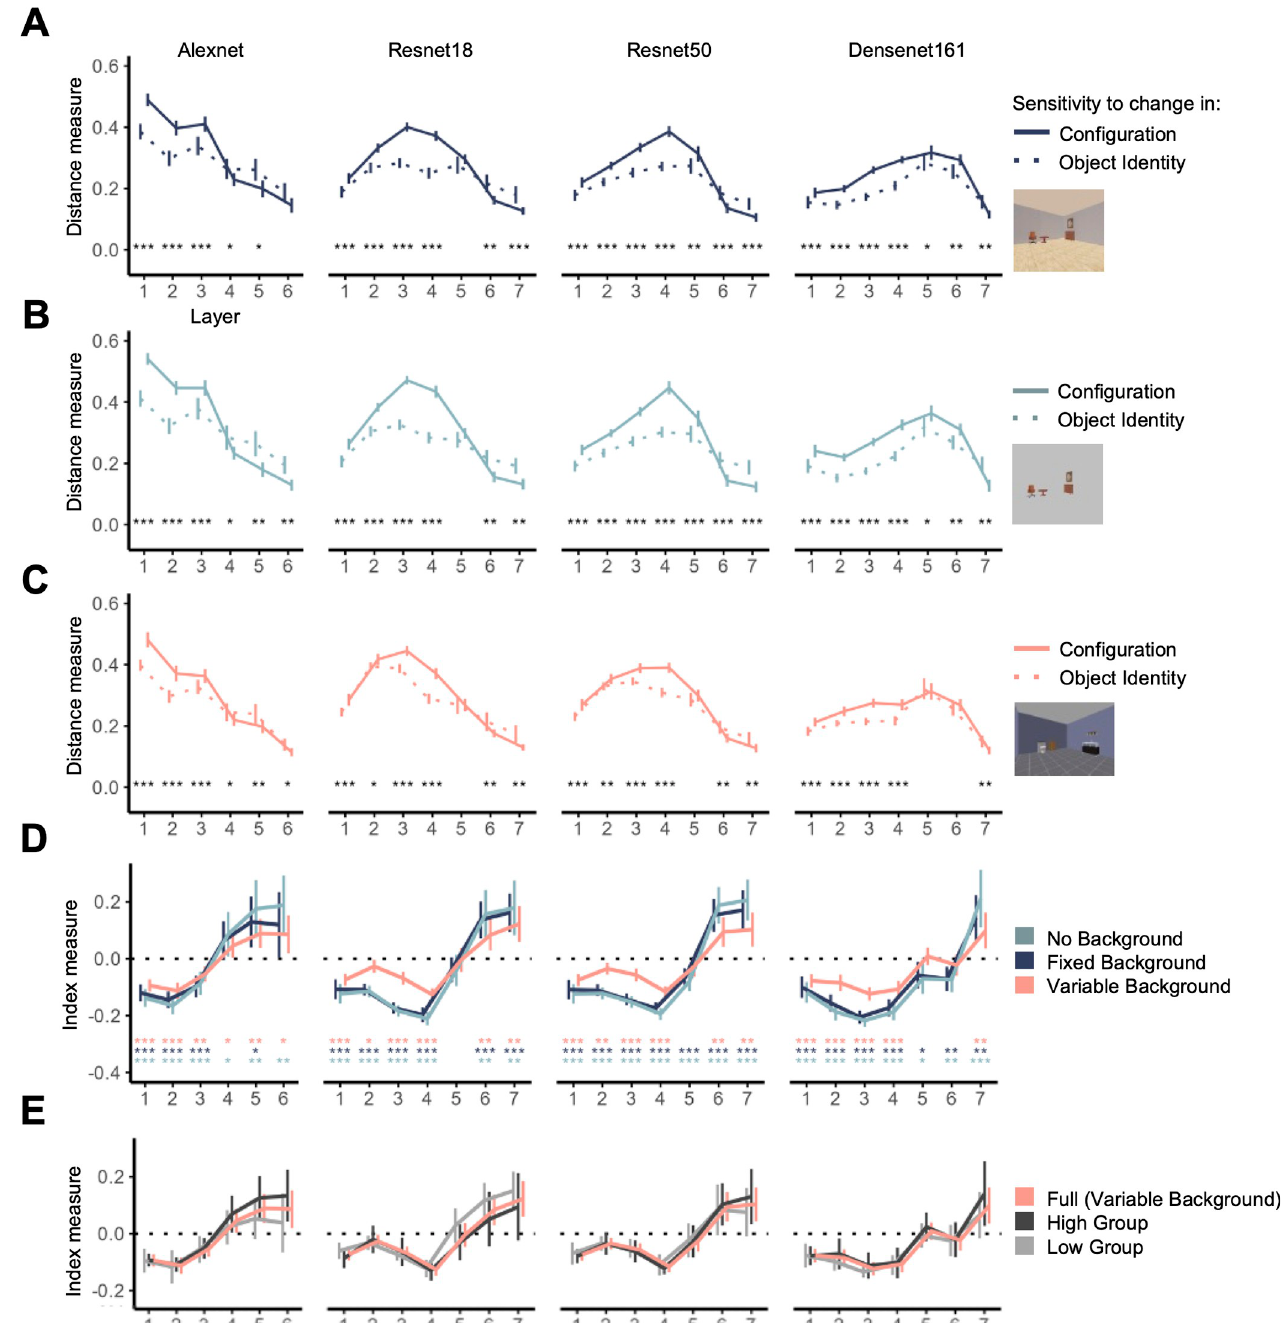
Fig 3. Euclidean distance and index measures quantifying a scene-trained CNN’s absolute and relative sensitivity to object identity and configuration changes for the different image collections. The Euclidean distance for “Configuration” was calculated as the distance between two images sharing the same objects but different configurations. The Euclidean distance for “Object Identity” was calculated as the distance between two images sharing the same configuration but different objects. The object dominance index measured the relative sensitivity to object identity and configuration changes, with negative values indicating greater sensitivity to configuration than identity changes and positive values the reverse. (A) Euclidean distances for “Fixed Background” image collection. (B) Euclidean distances for “No Background” image collection. (C) Euclidean distances for “Variable Background” image collection. ( D ) The object dominance indices for all three image collections. (E) The object dominance indices for “Variable Background” image collection separated by scene classification accuracy. High/Low/Full Group, indices for the top-half/bottom-half/full image sets. Error bars indicate 95% confidence intervals of the means. In (A), (B), and (C), asterisks indicate significance from pairwise comparisons between the Euclidean distance measures using two-tailed t-tests (all corrected for multiple comparisons). All values are significantly non-zero (ts > 10 , ps < 001 . ) In (D) the asterisks indicate the significance levels of the differences of each